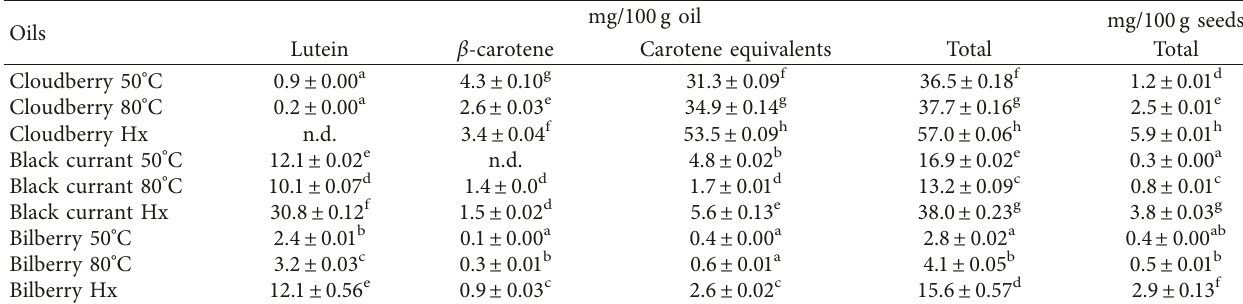
Table 3: Content of carotenoids in cloudberry, black currant, and bilberry seed oils extracted by SFE at different temperatures and by hexane